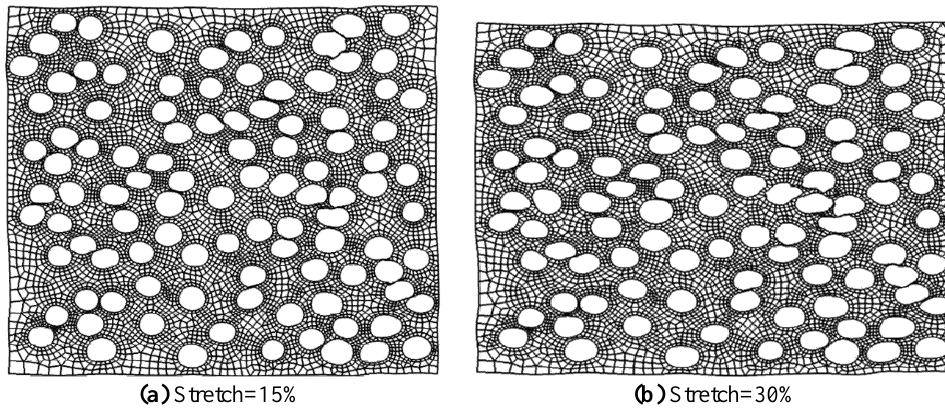
Figure 8. Deformed geometries of stretched membranes for ( a ) 15% stretch and ( b ) 30% stretch.